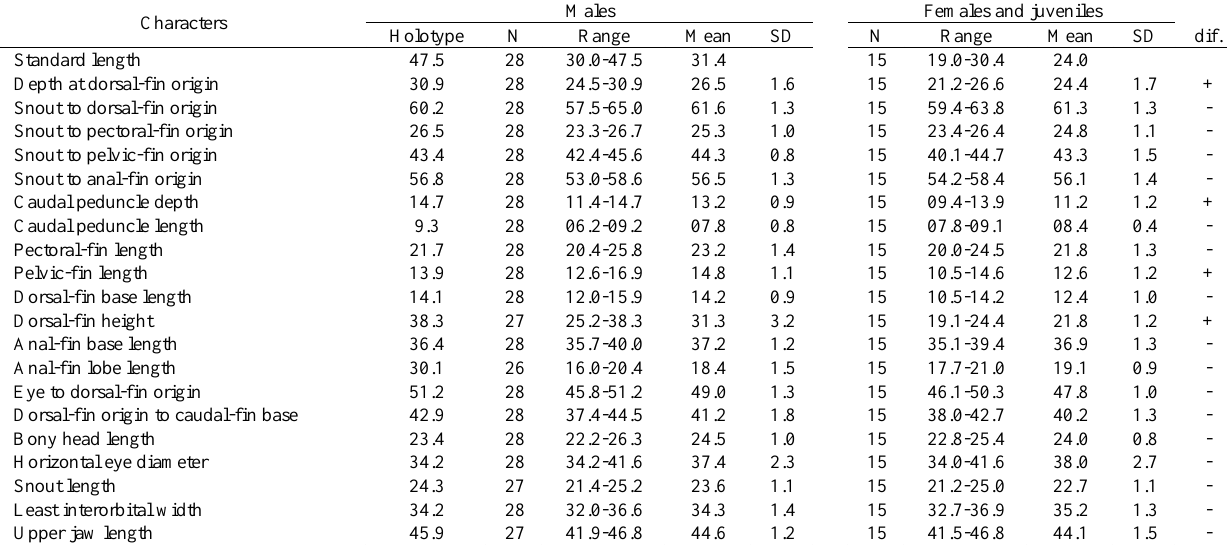
Table 12. Morphometrics of Mimagoniates microlepis . Standard length is expressed in mm; measurements through bony head length are percentages of standard length; the last four entries are percentages head length. A plus sign under the abbreviation dif indicates there is a significant statistical difference between the males and females in the particular character indicated. Specimens are from rio Macacu or some of its tributaries: NMW 56534 (lectotype), USNM 249896, MZUSP 14667, MZUSP 14668 and MZUSP 14669. SD = Standard